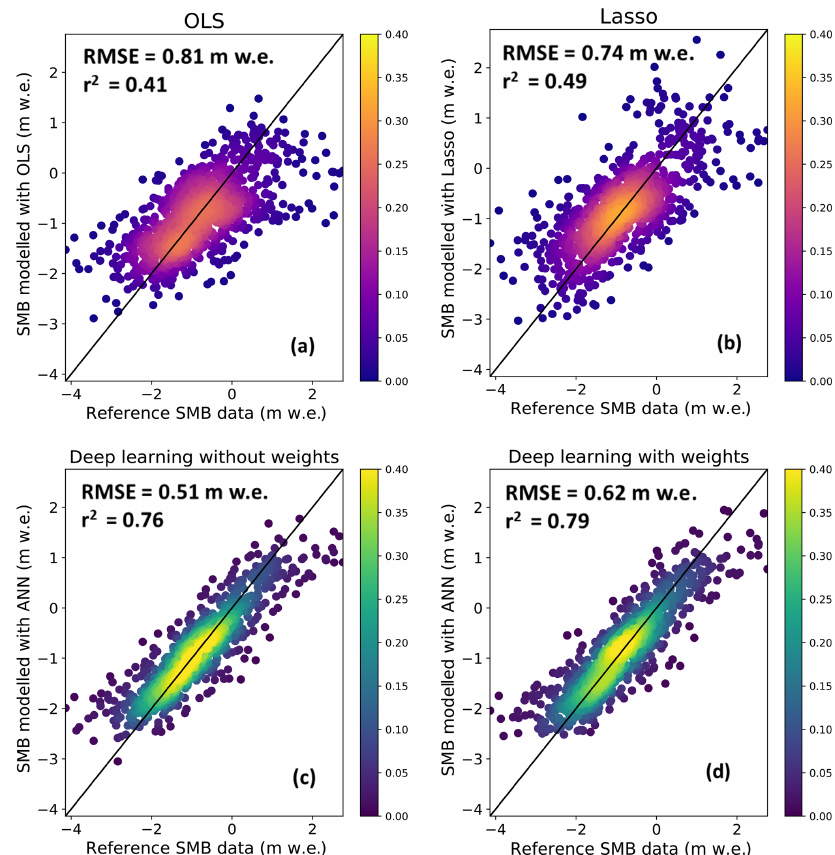
Figure 6. Evaluation of modelled annual glacier-wide SMB against the ground truth SMB data (both in mw.e.a − 1 ) using leave-one-glacier- out cross validation. The colour (purple–orange for linear; blue–green for nonlinear) indicates frequency based on the probability density function. The black line indicates the reference one-to-one line. (a) Scatter plot of the OLS model results. (b) Scatter plot of the Lasso linear model results. Scatter plots of the deep artificial neural network nonlinear models without (c) and with (d) sample weights.